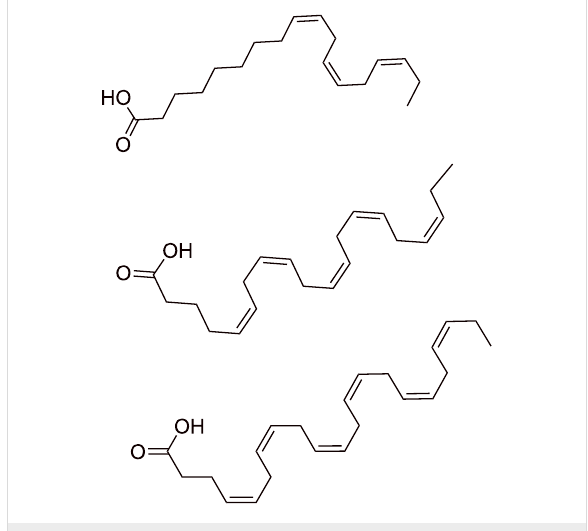
Figure 2: Structures of ALA, EPA and